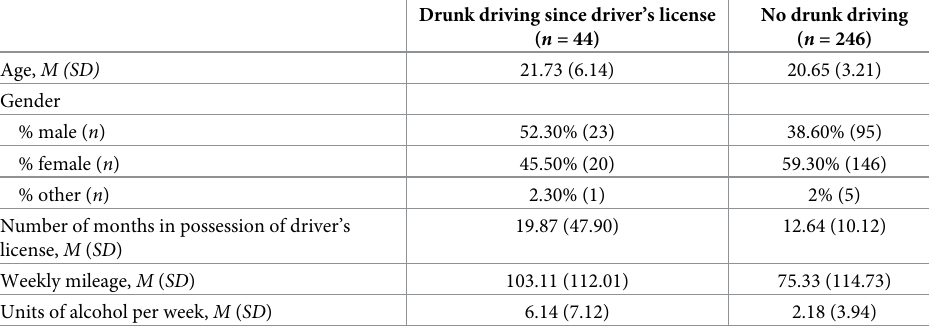
Table 1. Sample characteristics Study 1 per